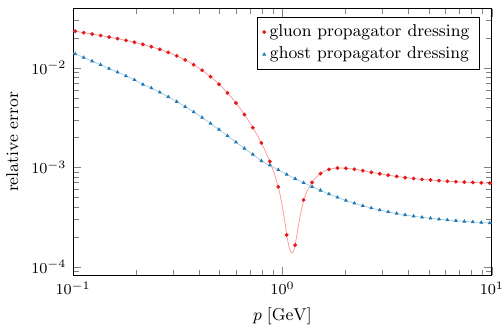
Figure 7: Relative errors ∆ of propagator dressings obtained with different regula- rel tor shape functions, given in (17) and (18), in the symmetric point